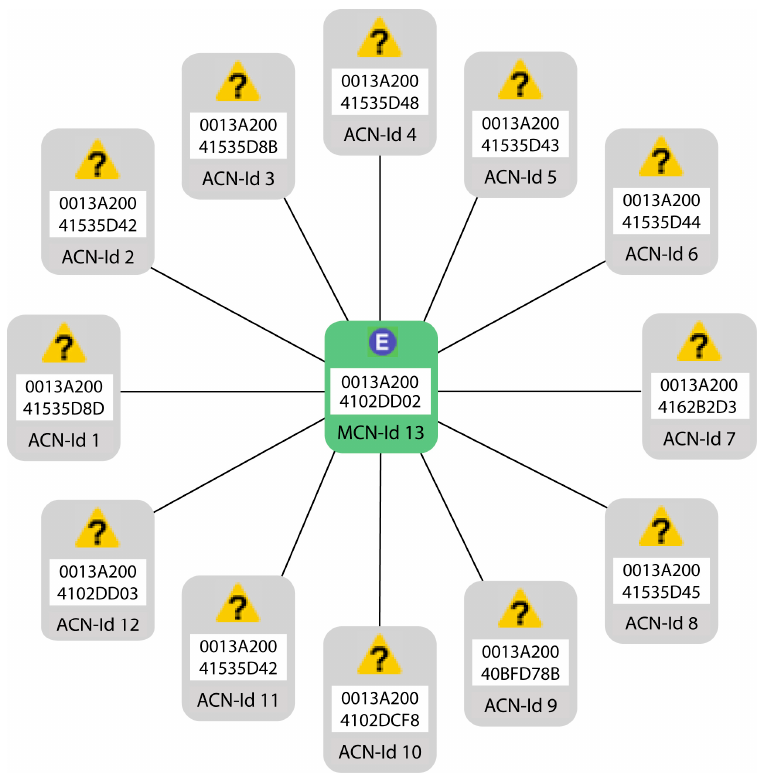
Figure 6. Overview of all of the Xbee modules connected in the star topology.